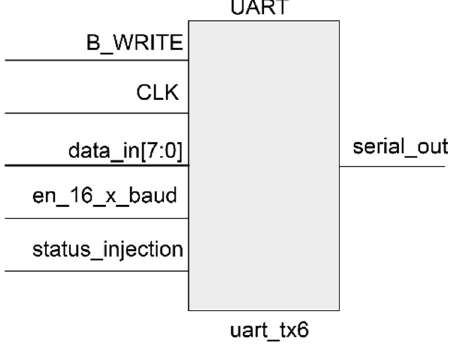
Figure 8. UART model.